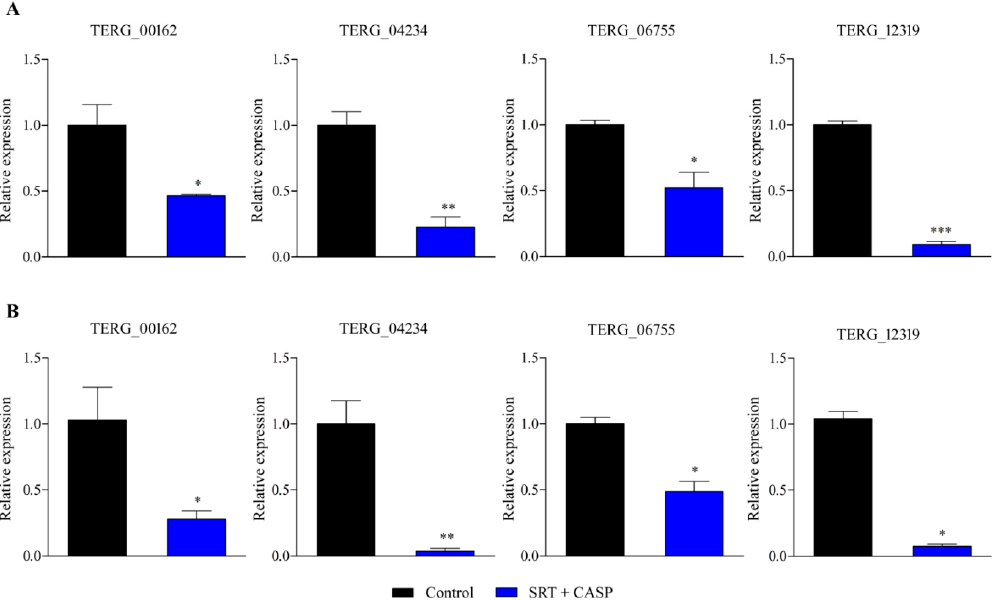
Figure 2. Genes encoding TERG_00162 (MFS multidrug transporter), TERG_04234 (Hydrophobin), TERG_06755 (C-8 sterol isomerase), and TERG_12319 (Chitin synthase 2) are differentially ex- pressed in response to combinations of SRT with CASP. Asterisks indicate statistical significance determined by t -test as compared to the control (SB absence drug) at 3 h ( A ) and 12 h ( B ); * p <0.05; ** p < 0.01; *** p <